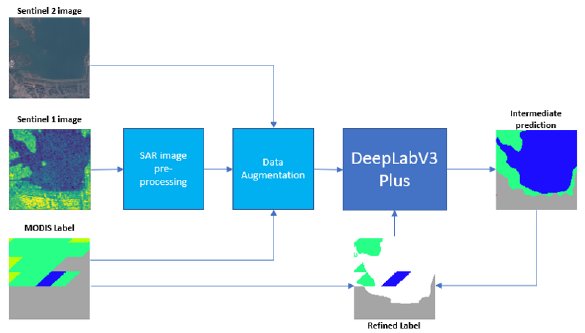
Figure 1: Framework overview of the proposed model